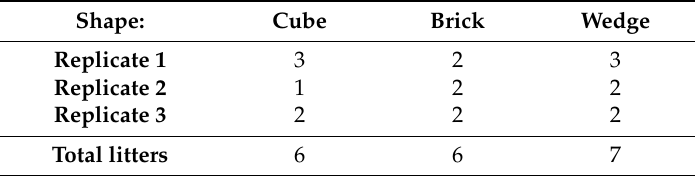
Table 2. Number of litters in each block shape treatment per replicate (farrowing batch).